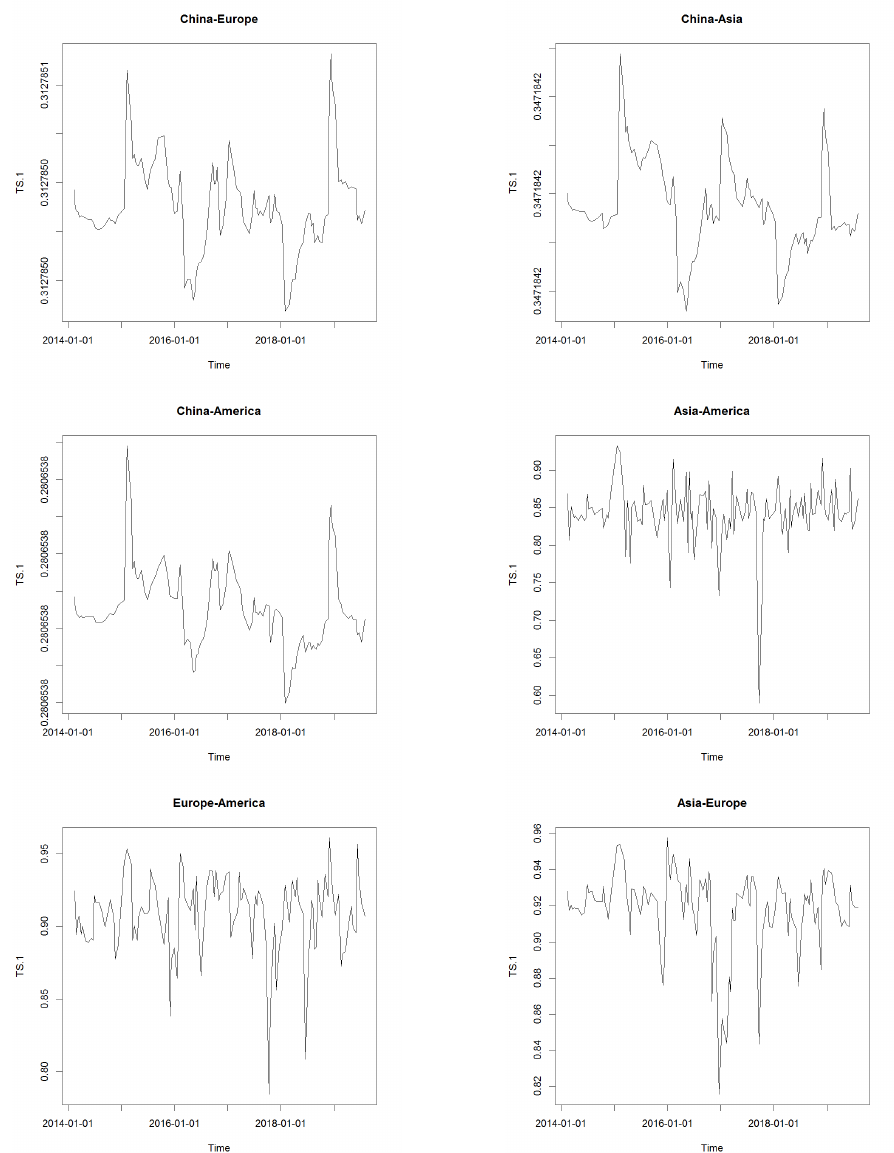
Fig. 2 Dynamic correlation coefficient of diesel price